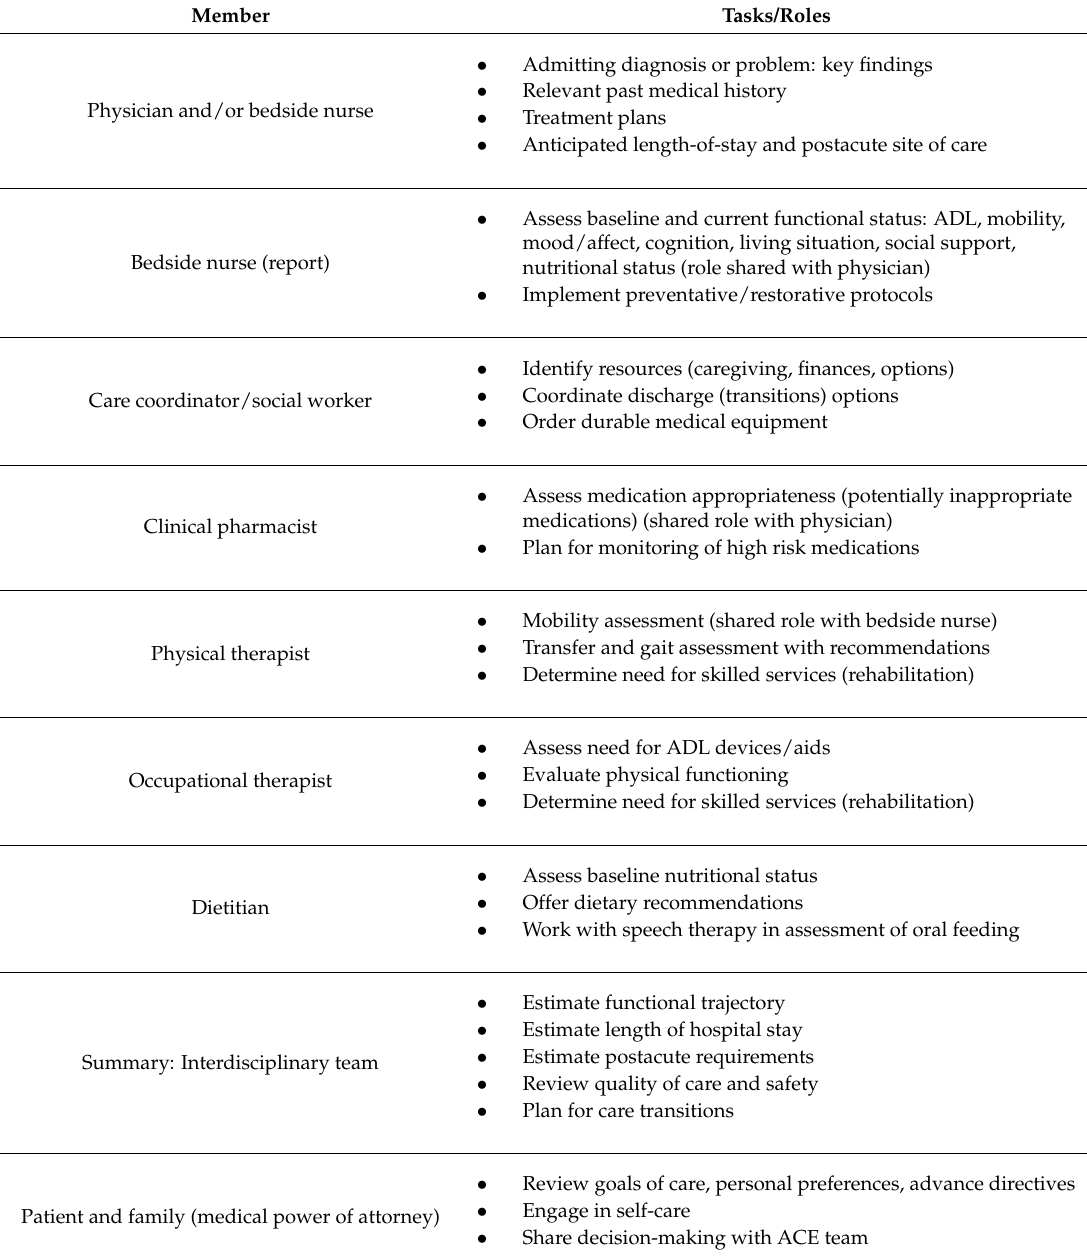
Table 2. Interdisciplinary Team Members, Tasks and